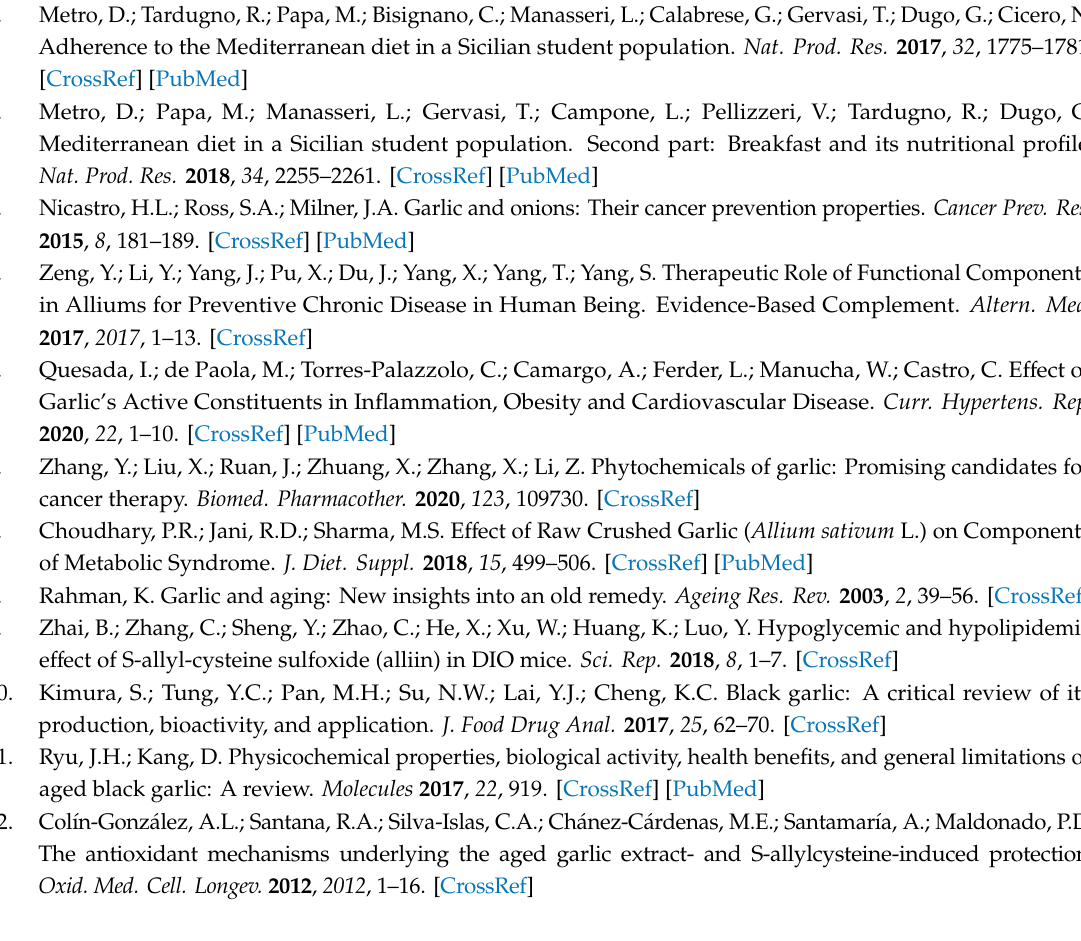
Table S1: Concentrations of electrolytes Simulated Salivary Fluid (SSF), Simulated Gastric Fluid (SGF) and Simulated Intestinal Fluid (SIF); Table S2: HPLC-HRMS-Based Identifications of (poly)phenols in fresh and black garlic; Table S3: HPLC-HRMS-based identification of organosulfur compounds in fresh and black garlic. Author Contributions: The authors’ responsibilities were as follows: Conceptualization: J.M.M.-R., G.P.-C.